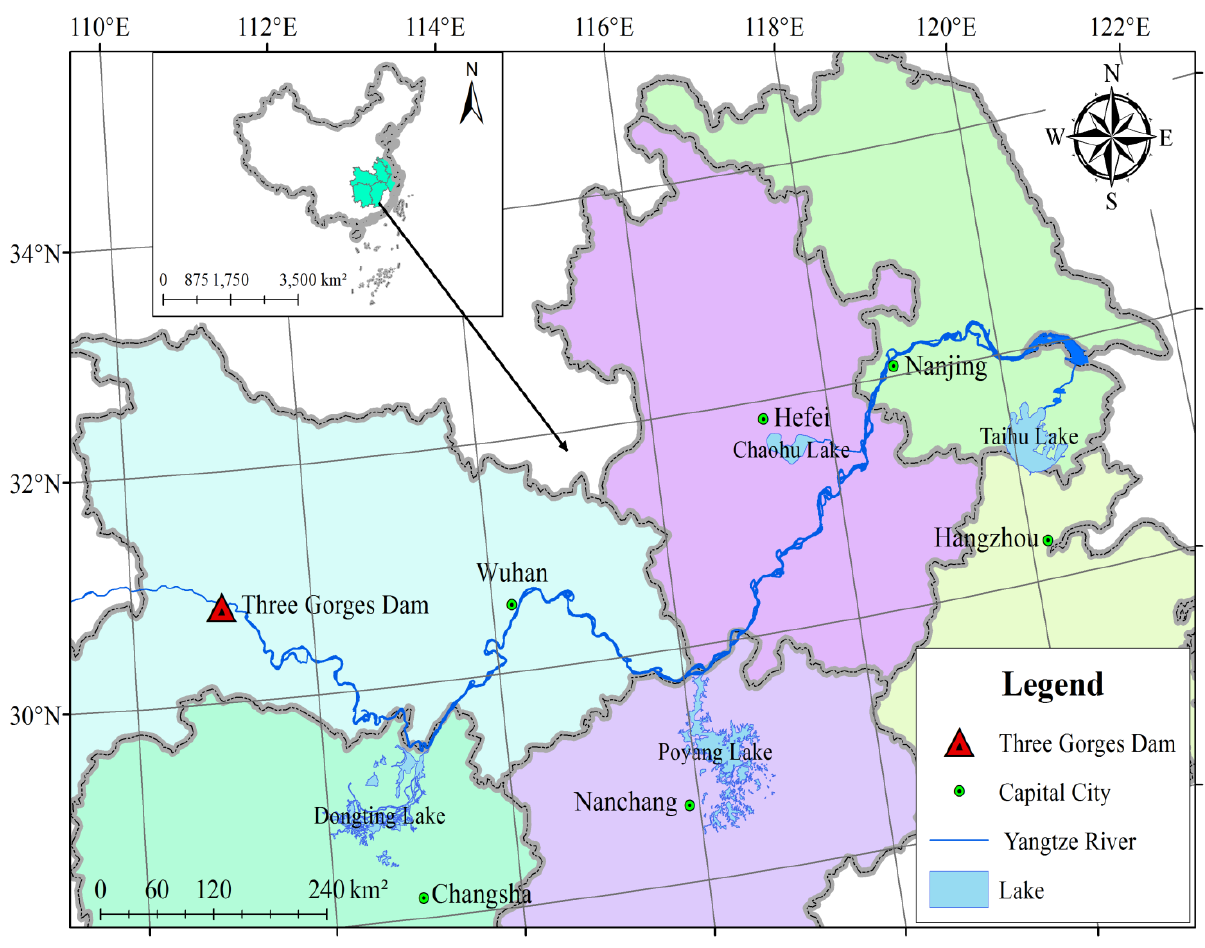
Figure 1. The study area and locations of the four lakes in